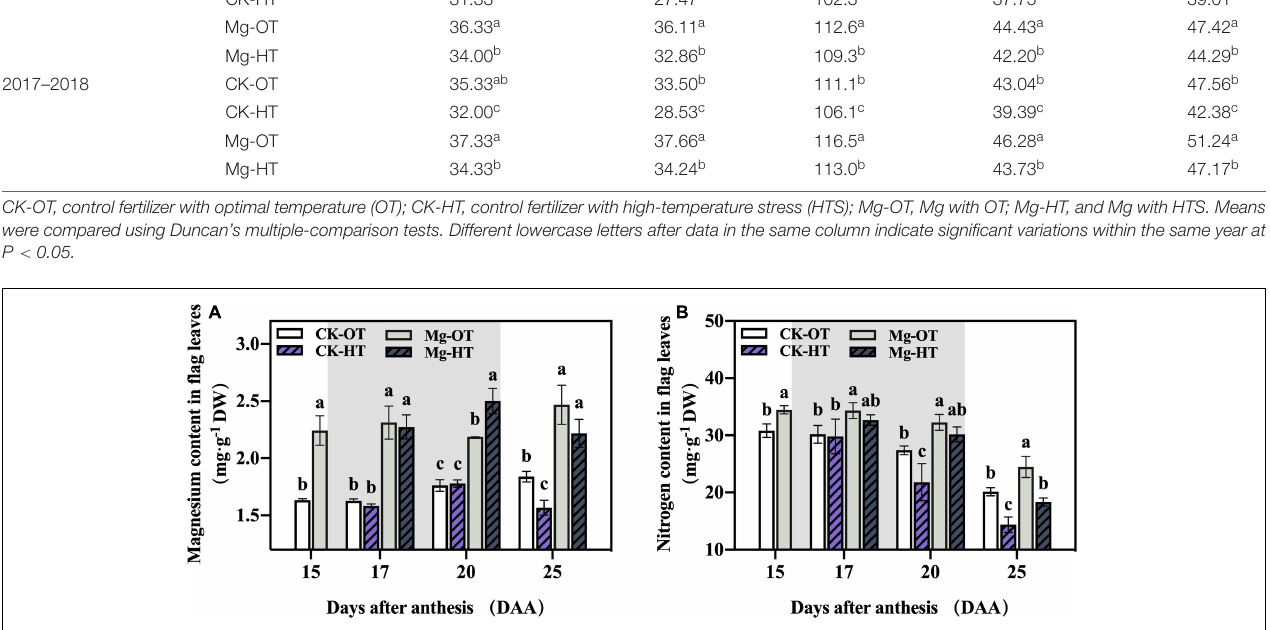
FIGURE 1 | Effect of Mg application on magnesium content (mg · g − 1 DW) (A) and nitrogen content (mg · g − 1 DW) (B) under high-temperature stress during the grain filling. Treatments: CK-OT, control fertilizer + optimal temperature; CK-HT, control fertilizer + high temperature; Mg + OT, Mg fertilizer + optimal temperature; Mg + HT, and Mg fertilizer + high temperature. The shaded area indicates the high -temperature treatment period. Two-way analysis of variance was performed, and the means were compared using Duncan’s multiple-comparison tests. Different lowercase letters indicate significant variations within the same day at P < 0.05 ; the error bars represent standard error (SE) of three biological